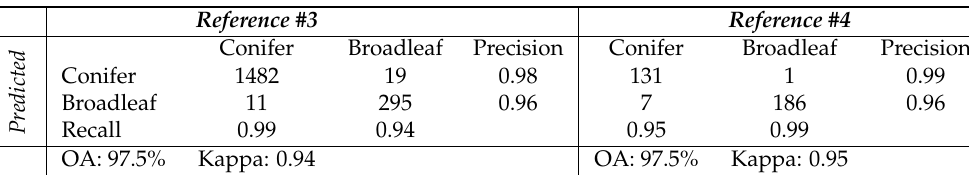
Table 13. Results for the classification of conifers and broadleaf trees. Šumava National Park: Test data are from reference areas Bioklim CZ , B 1 and B 2: 3480 conifers and 712 broadleaf trees for training. 1493 conifers, 314 broadleaf trees for testing (=Reference #3). 138 conifers, 187 broadleaf trees for testing (=Reference #4 only from Bioklim CZ